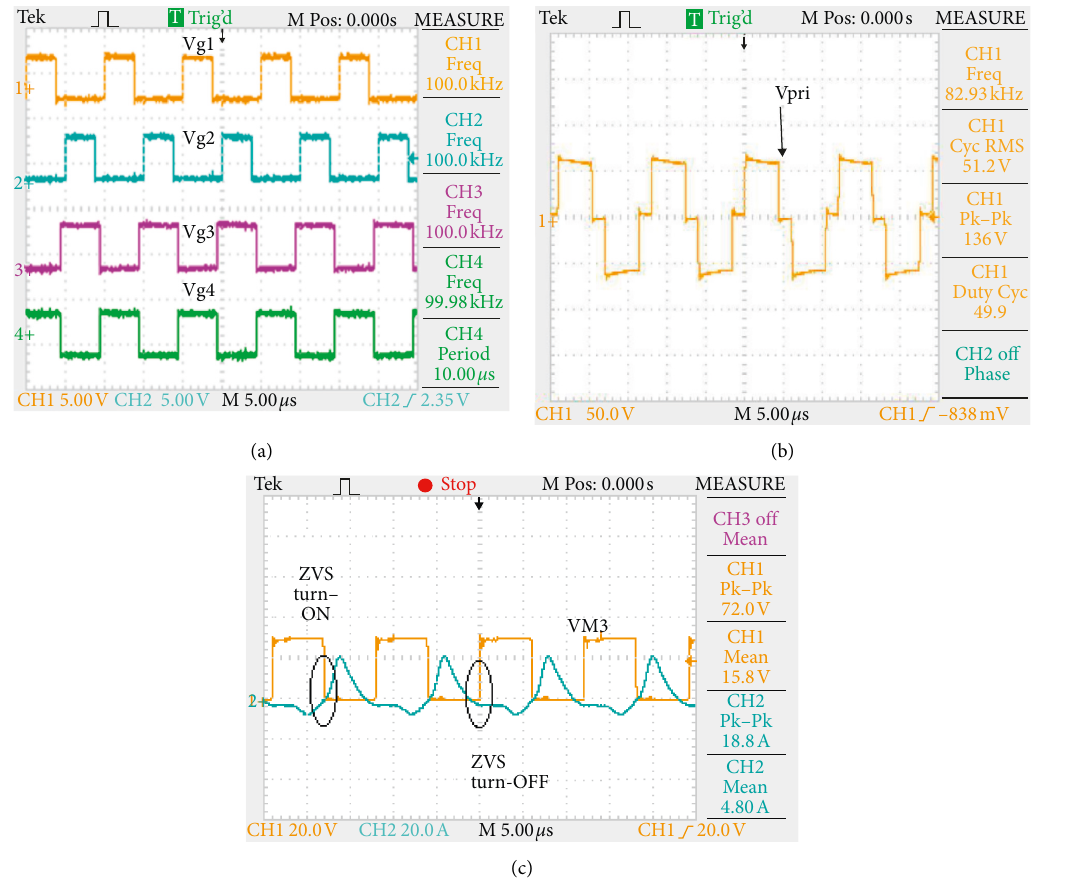
Figure 11: (a) Gating pulses to Switches M 1 ( Vg 1 ) , M 2 ( Vg 2 ) , M 3 ( Vg 3 ) , and M 4 ( Vg 4 ) , (b) Transformer primary voltage for 100W, and (c) ZCS turn-on and turnoff of diodes for 180